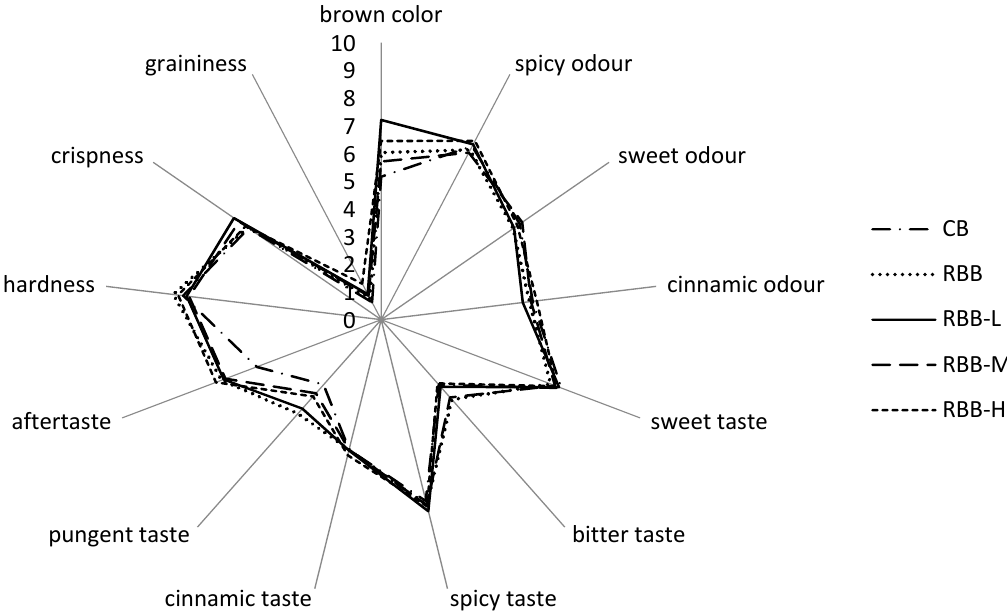
Figure 1. Aroma profiles of control (CB), rye-buckwheat biscuit (RBB) and RBBs with low, medium and high rutin addition (RBB-L, RBB-M, RBB-H, respectively).